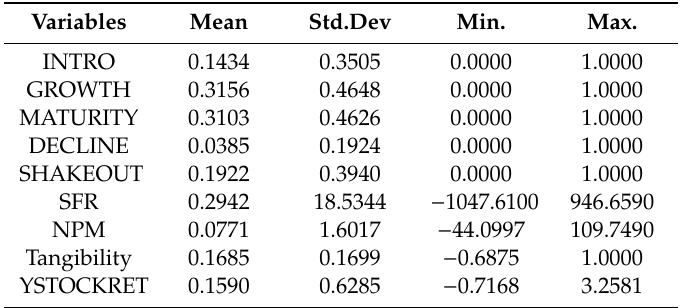
Table 3. Descriptive Statistics for the Independent and Control